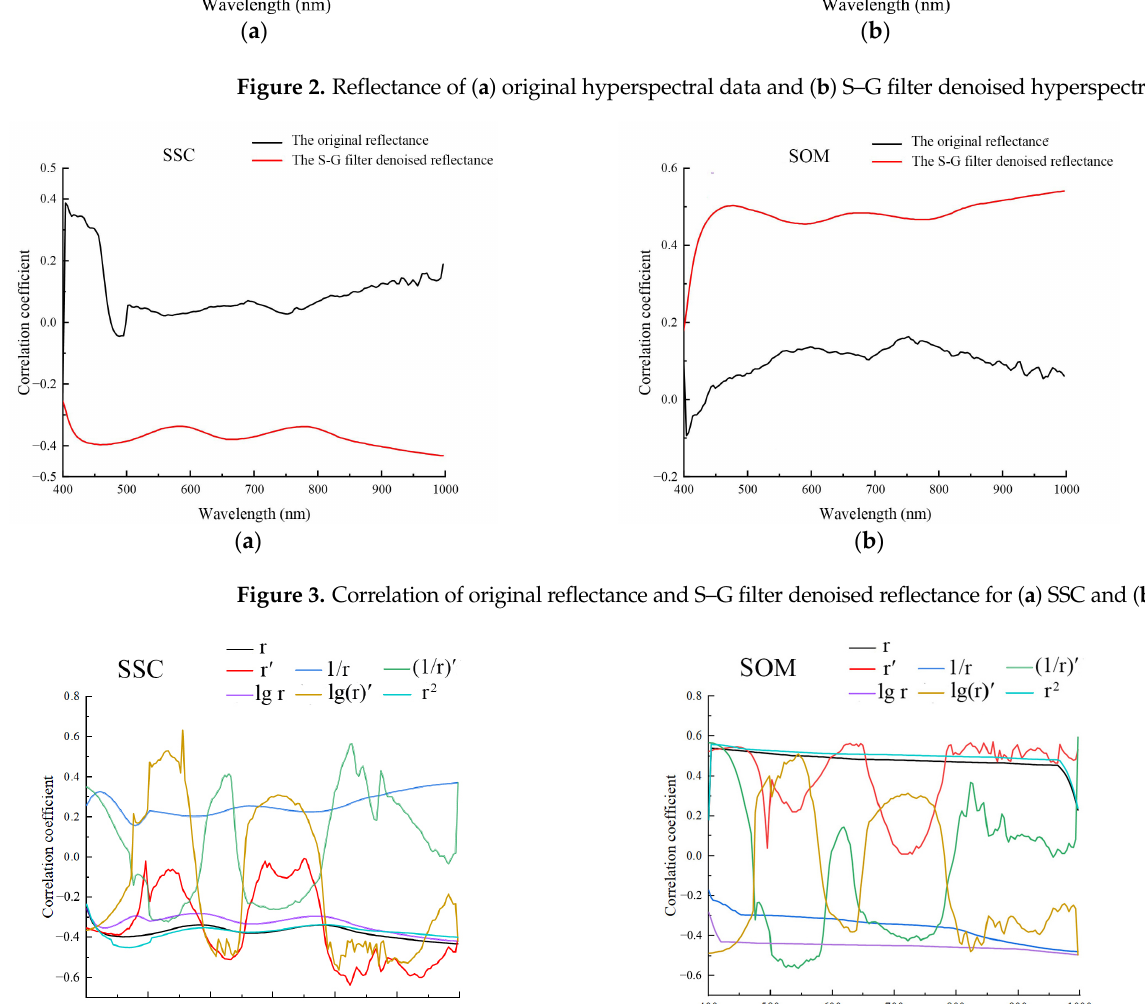
Figure 2. Reflectance of ( a ) original hyperspectral data and ( b ) S–G filter denoised hyperspectral data.